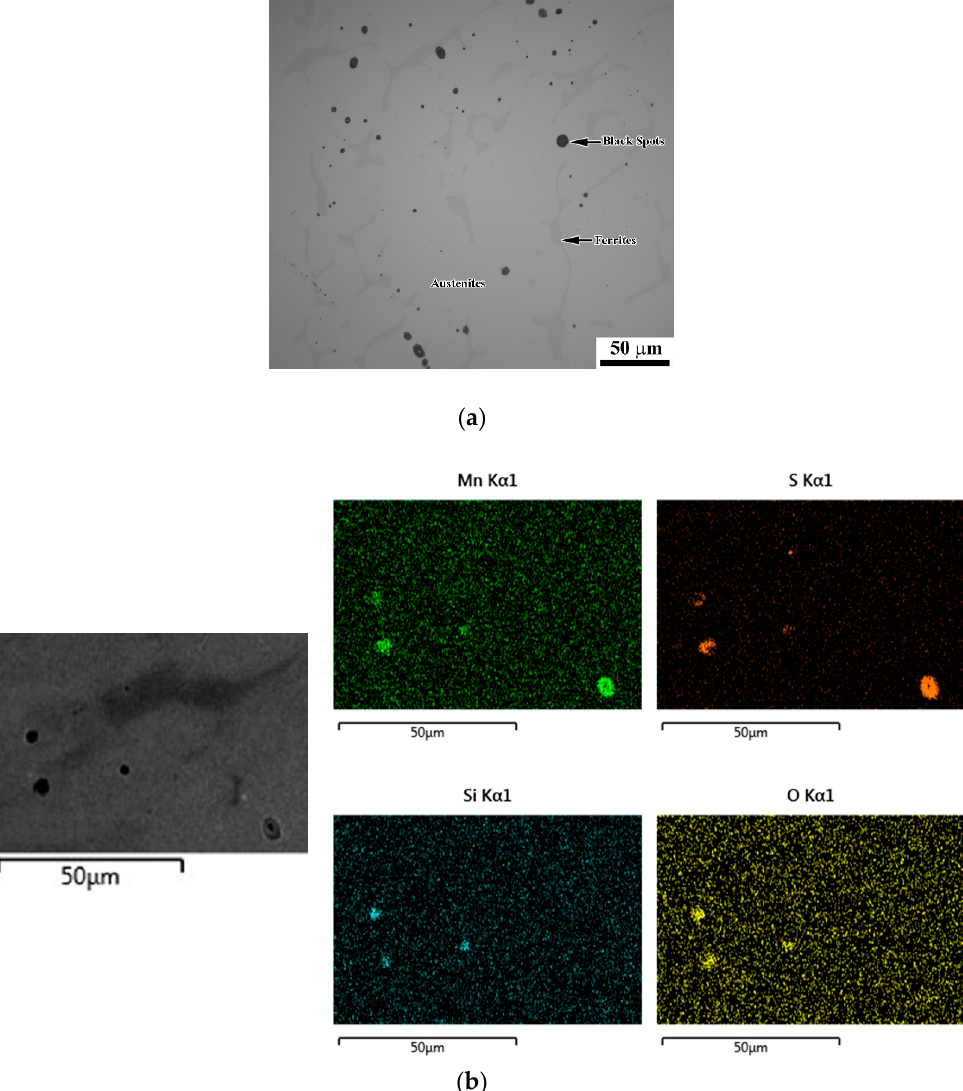
Figure 3. The OM observation and EDS mapping of the base metal: ( a ) OM micrograph, and ( b ) SEM micrograph and elemental mappings.